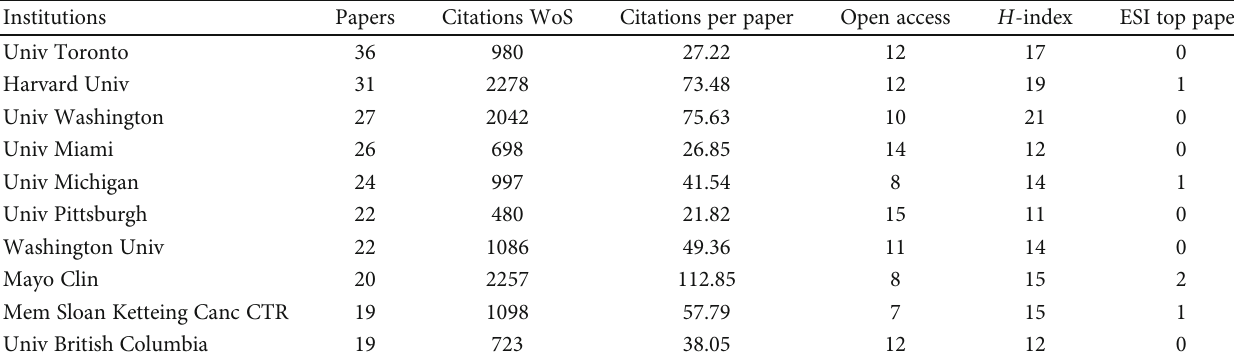
Table 2: The top 10 institutions of origin of papers in neuropathic pain rehabilitation research.